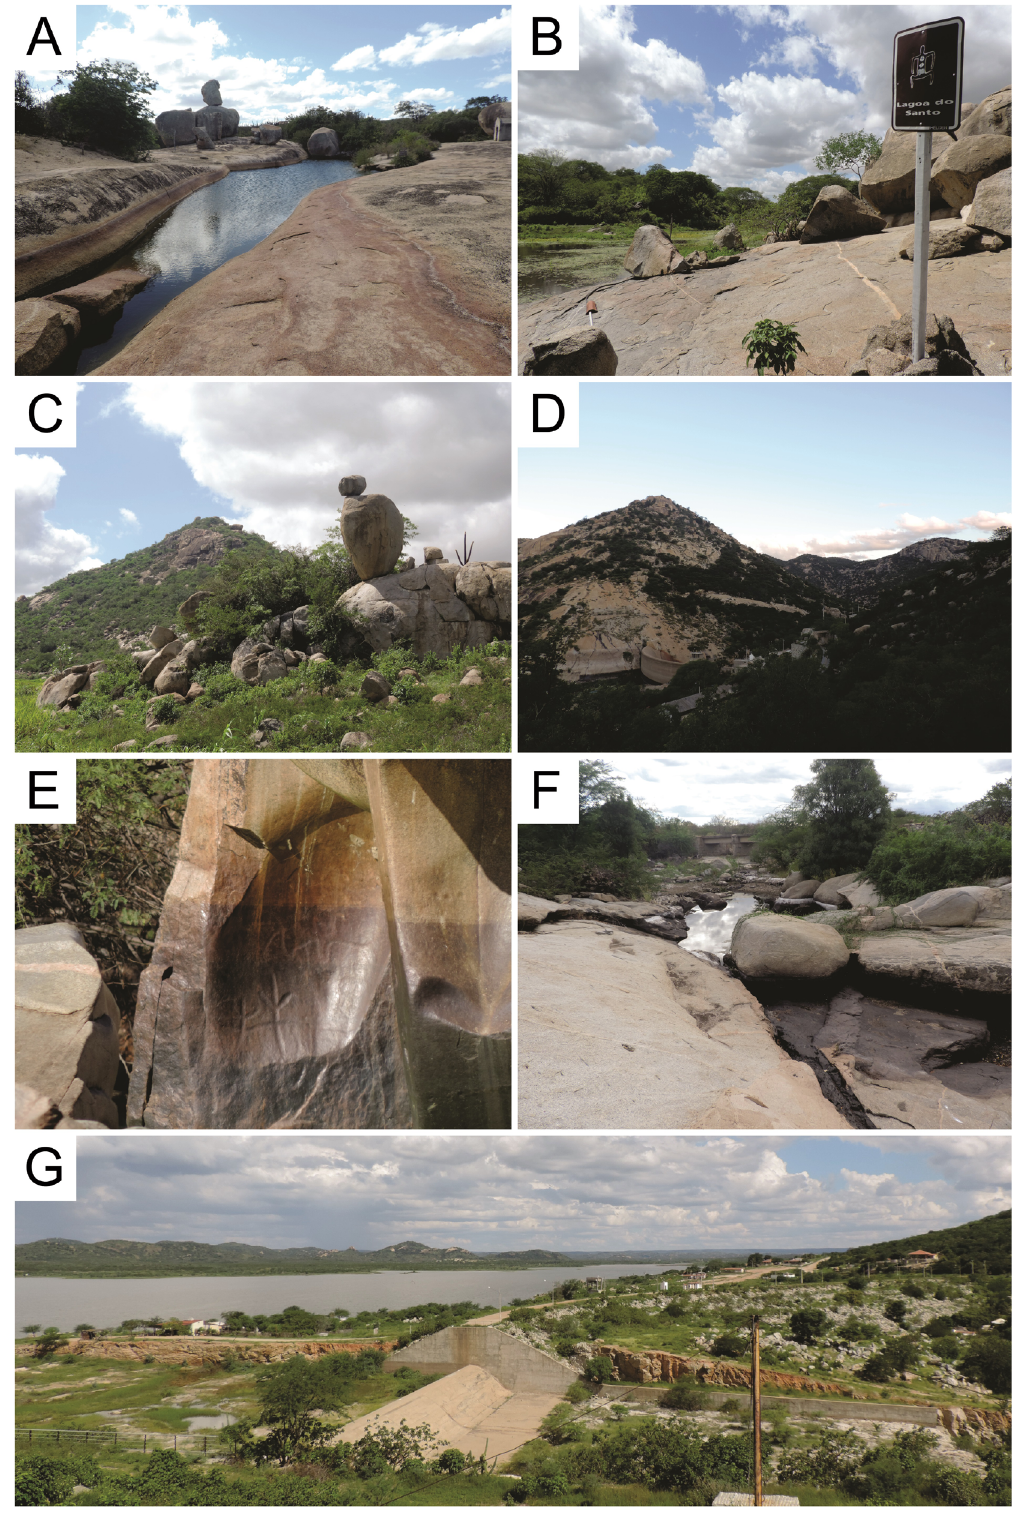
Figure 5. Main geosites from the Seridó Aspiring Geopark according to the evaluation carried on this work: A) Serra Verde. B) Lagoa do Santo. C) Pico do Totoró. D) Açude Gargalheiras. E) Poço do Arroz. F) Marmitas do Rio Carnaúbas. G) Açude Boqueirão. Photos: Matheus